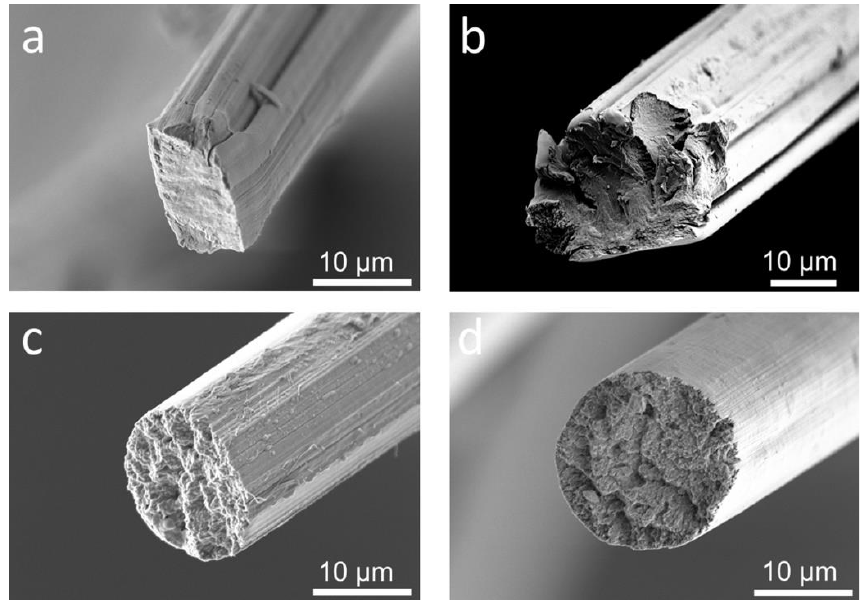
Figure 3. SEM images of wet-spun cellulose precursors with ( a ) 0 wt% lignin in System S, ( b ) 30 wt% lignin in System S, ( c ) 0 wt% lignin in System P, and ( d ) 30 wt% lignin in System P.